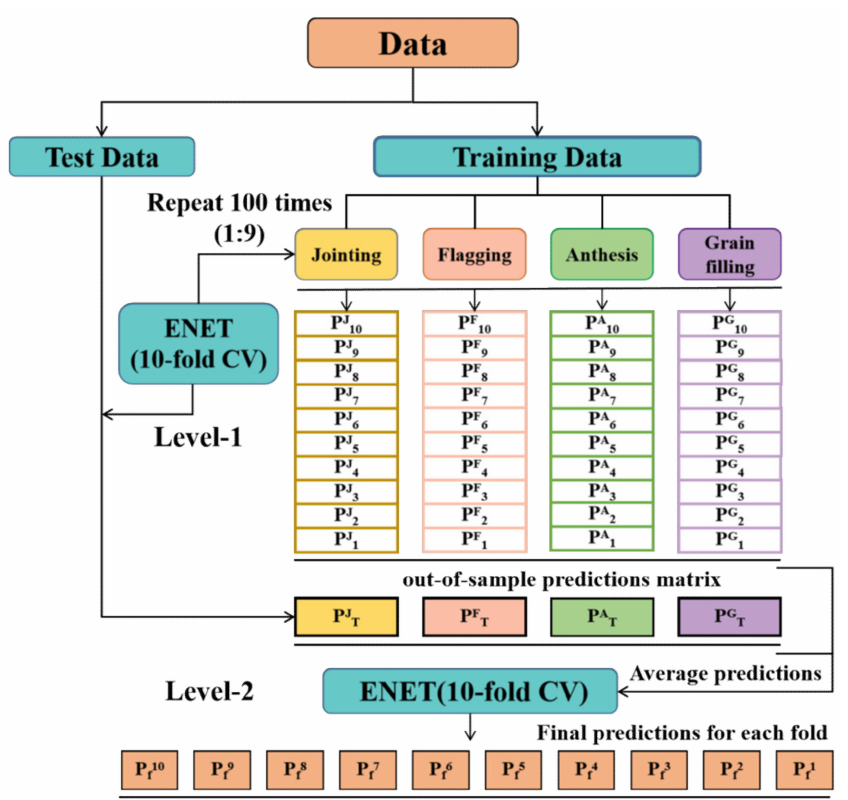
Figure 3. The workflow of the stacking regression model for predicting grain yield. In the figure: CV, cross-validation; P, prediction values of grain yield; J, jointing; F, flagging; A, anthesis; G, grain